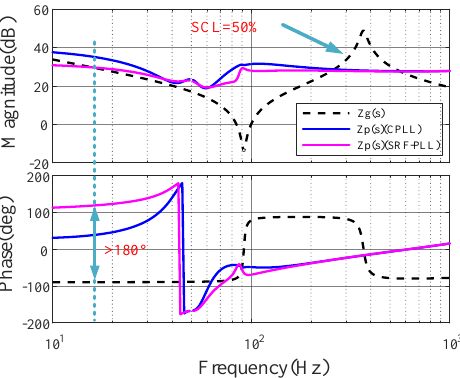
Figure 8. Impedance characteristic curve of the inverter after PLL impedance reshaping.